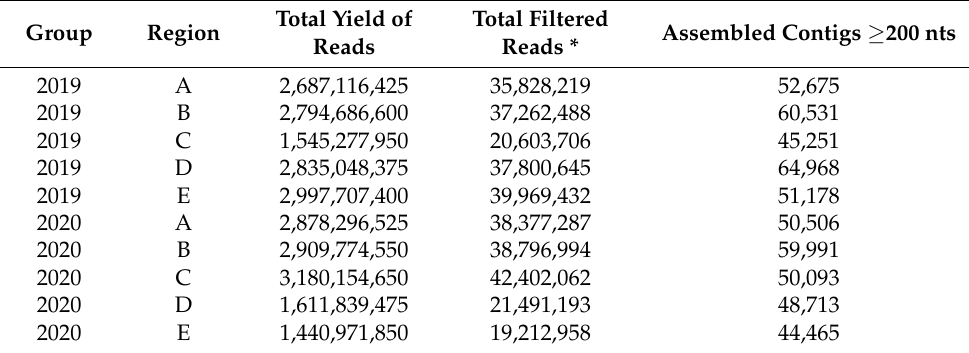
Table 2. Summary of RNA-sequencing results generated from cDNA libraries of Groups 2019 and 2020 during HTS